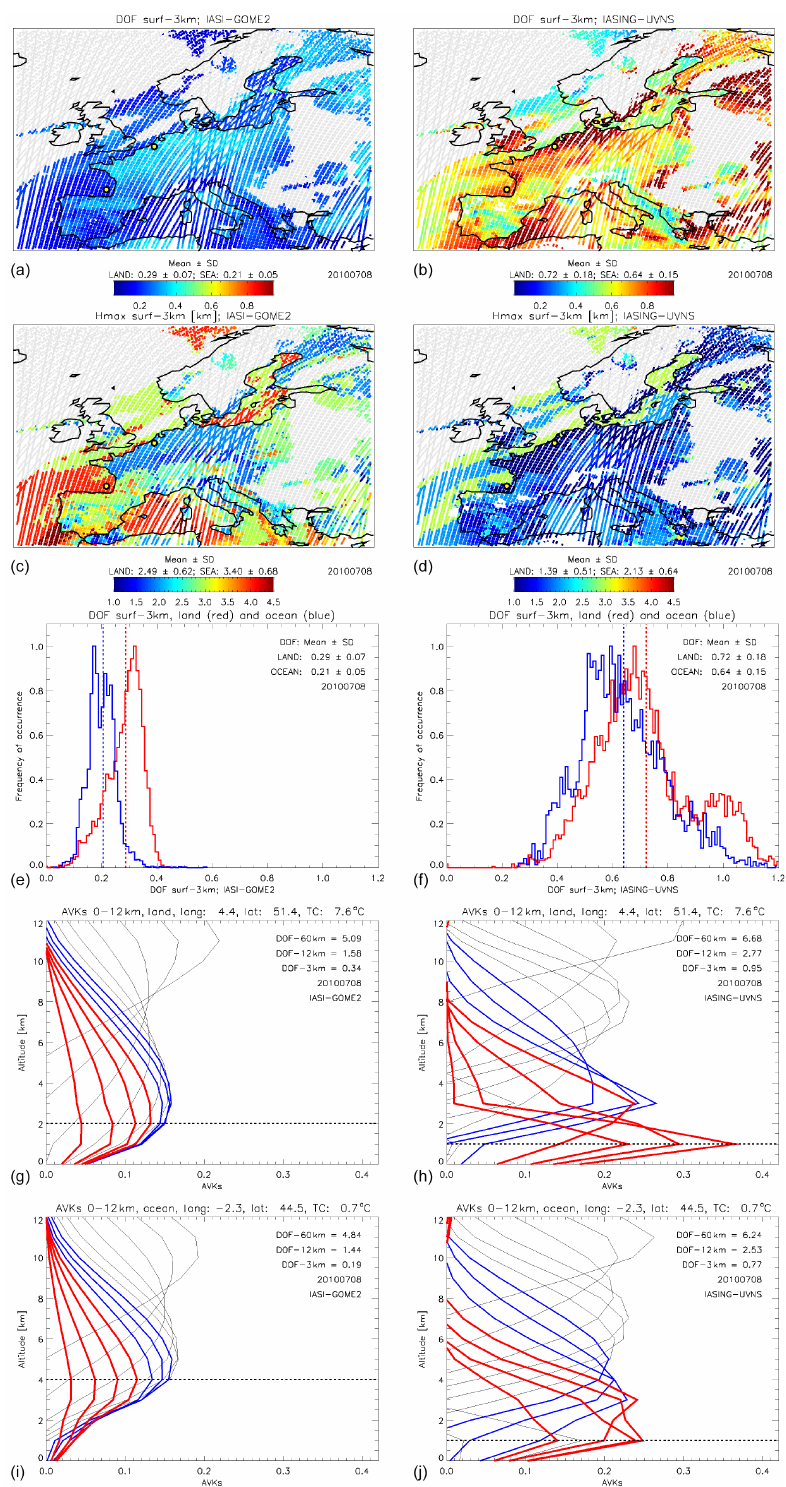
Figure 4. IASI + GOME-2 (a, c, e, g, i) and IASI-NG + UVNS (b, d, f, h, j) data, for 8 July 2010. (a, b) Maps of DOF-3km from pseudo- observations (POs), grey colour indicates where CLF is larger than 0.3. (c, d) Maps of Hmax-3km [km] from POs. (e, f) Histograms of DOF-3km normalized frequency distribution from POs over land (red) and ocean (blue). (g, h) AVK vertical profiles at retrieval altitudes of 0, 1, 2, 3km (red) and 4, 5, 6km (blue) and 7, 8, 9, 10, 11, 12km (black) for a pixel over land (black-yellow spot in the map) in a highly polluted area. Values of DOF-60km, DOF-12km and DOF-3km are reported in the figure. Dashed line indicates the altitude of maximum sensitivity in the LMT. (i, j) Same as before but over